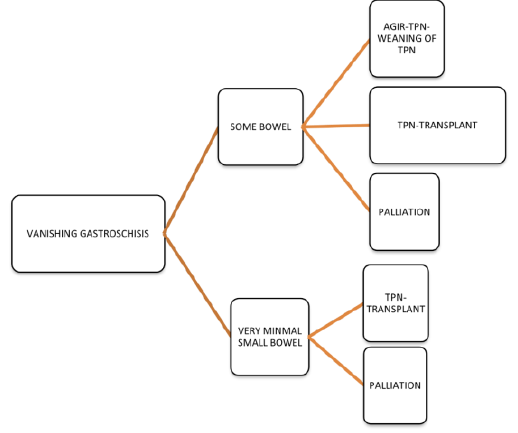
Figure 3: Approach for neonates with Vanishing Gastroschisis. (AGIR: autologous gastrointestinal